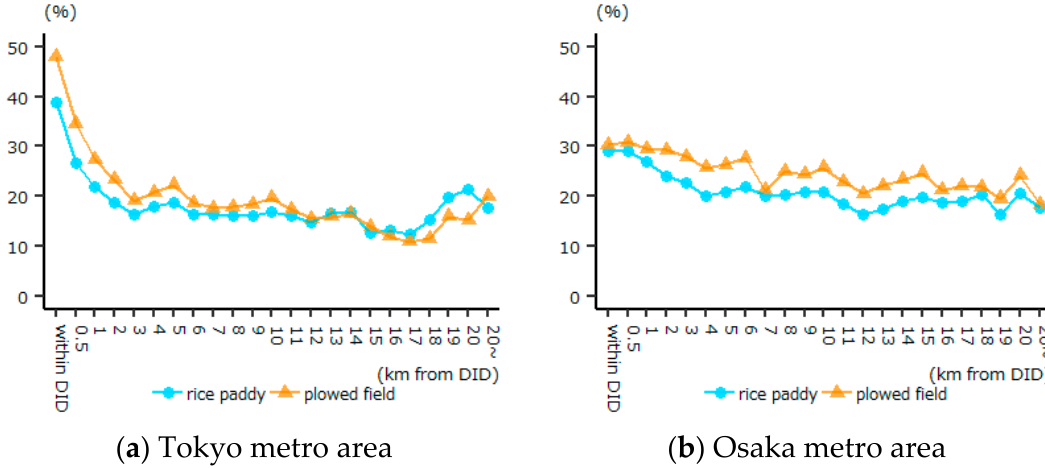
Figure 9. Average diversified farms rate by distance from DID. ( a ) shows the case of Tokyo metro area and ( b ) shows the case of Osaka metro area. Note: The average diversified farms rate is calculated by relating the rate per agricultural community unit to farmland parcels by using GIS software.